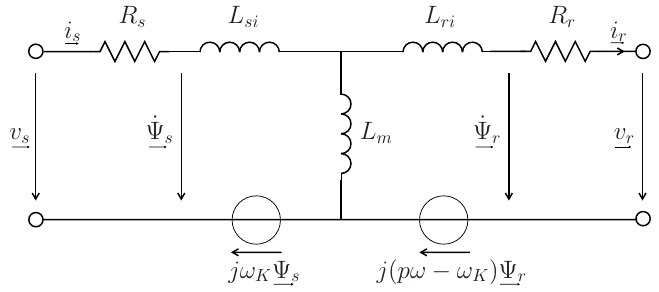
Figure 2. Equivalent space vector circuit diagram of